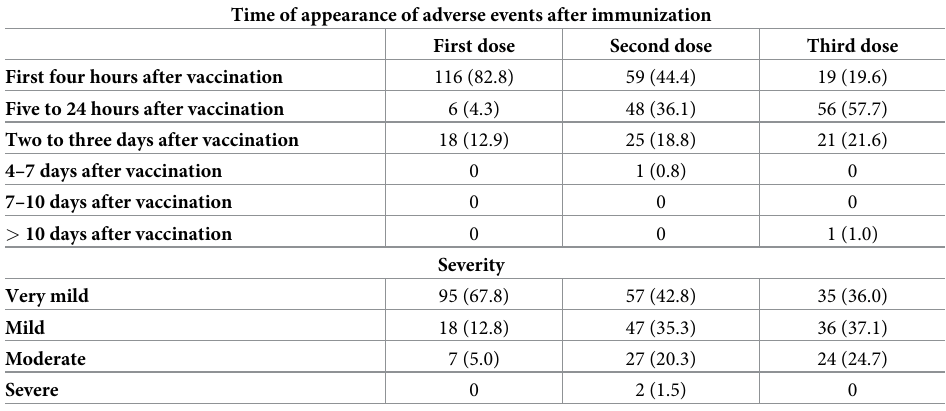
Twenty-one to 28 days after the administration of the third BNT162b2 booster, the quanti- tative SARS-CoV-2 spike 1–2 IgG antibody titers increased drastically. Participants with a neg- ative SARS-CoV-2 infection increased their antibody titers over six-fold in comparison with the previous results obtained 1–7 days after the third dose; in positive SARS-CoV-2 infection cases, titers increased four-fold. According to our mixed model, when we compared the esti- mates from days 21–28 after the second dose and 21–28 after the third dose, there was a greater increase in antibody levels after the third dose. Table 6. Time of appearance and severity of AEFI after each BNT162b2 dose.